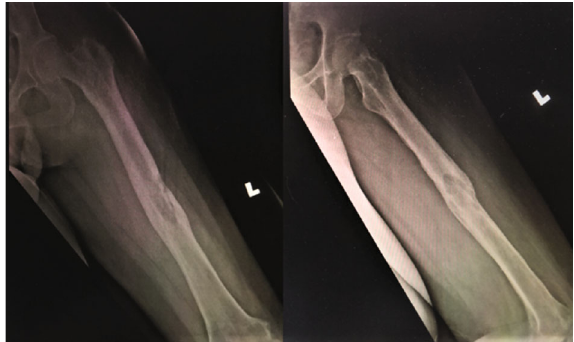
Figure 6: X-rays left femur at 6 months